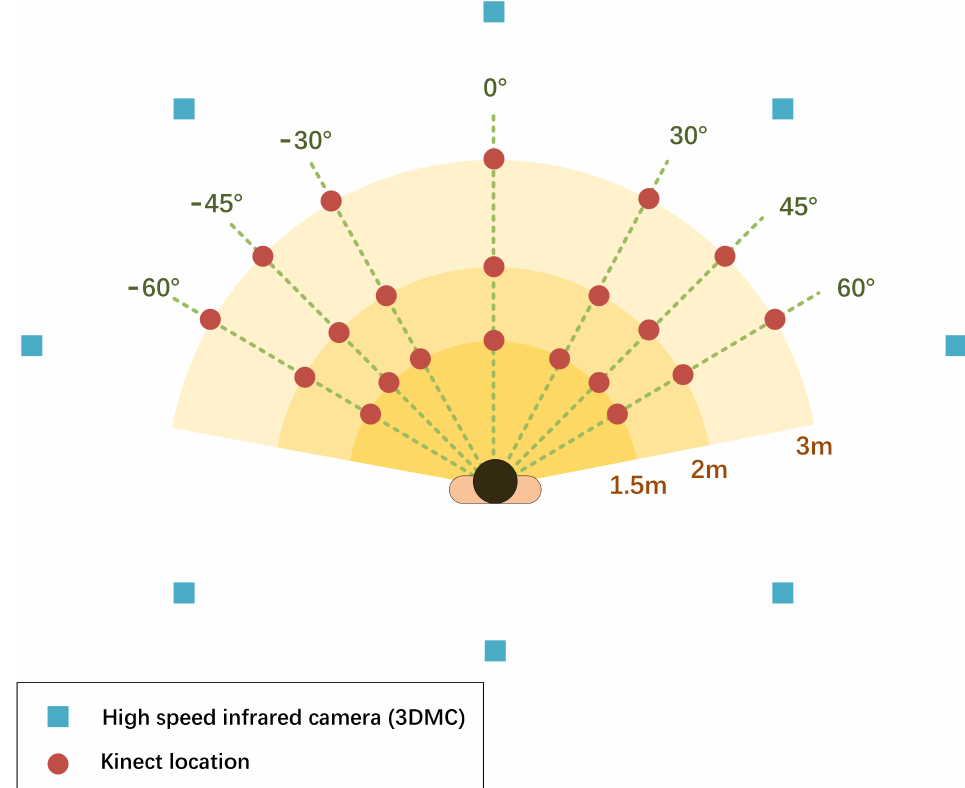
Figure 2. Kinect locations specified by distance and orientations relative to the subject. A Kinect sensor is placed at 21 locations at three different distances and seven orientations. Specifically, a Kinect sensor is place at 1.5 m, 2 m, and 3 m far from a subject. For each distance, a Kinect sensor is placed at seven orientations, right in front of the subject 0 ◦ , 60 ◦ , 45 ◦ , and 30 ◦ to the left side (represented by negative values) and right side of a subject (represented by positive